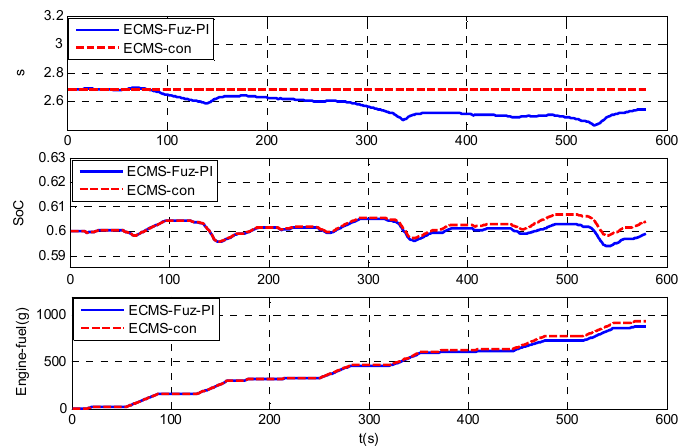
Figure 18. Comparison of performance using two kinds of EF (3 × ECE).